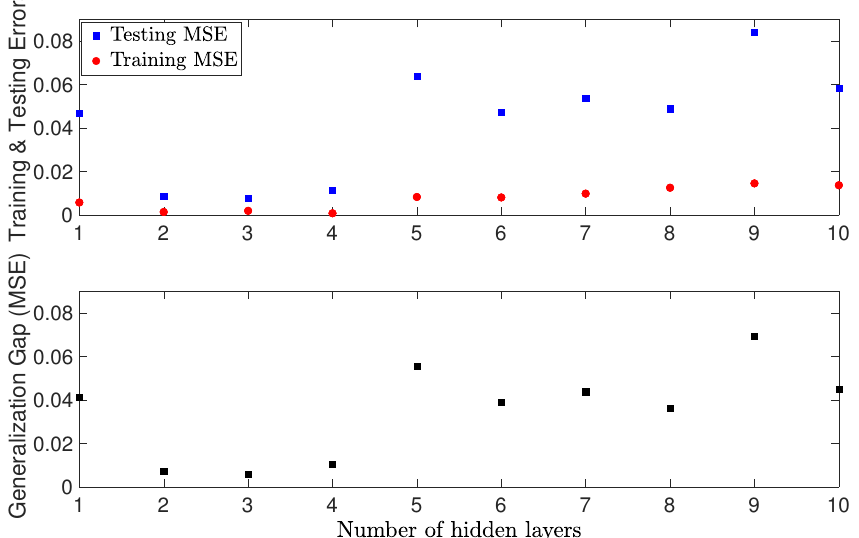
Figure 4. RNN generalization performance vs. RNN depth (Increasing the number of hidden layers and fixing 5 neurons for each